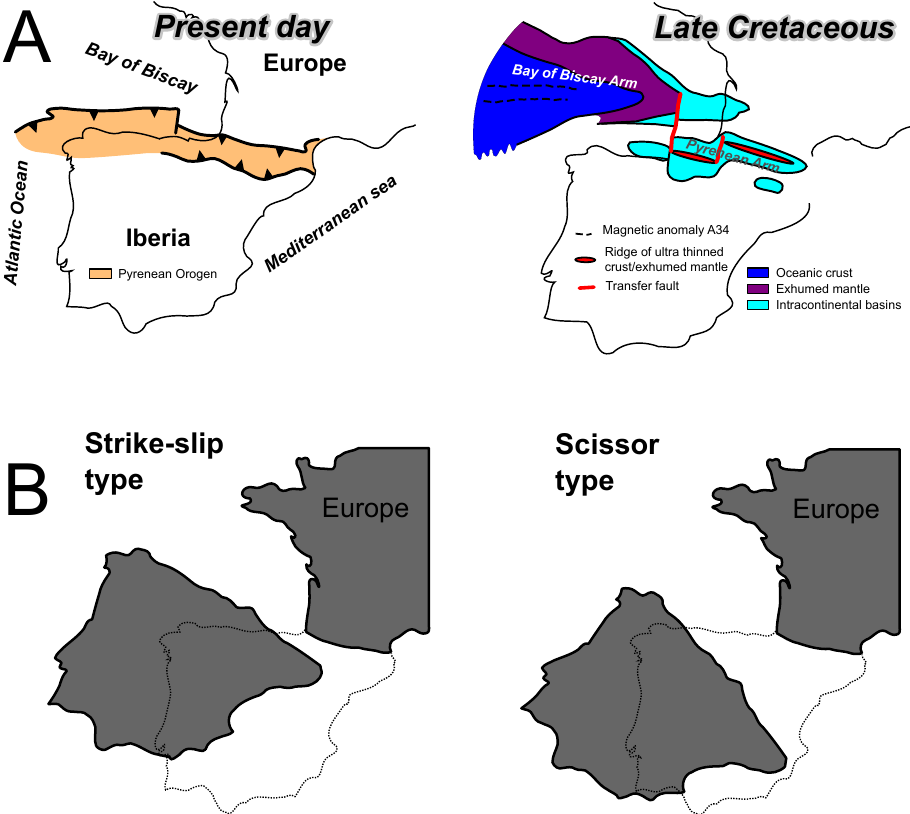
Fig. 1. (A) Present-day and reconstructed Late Cretaceous tectonic sketch map of the Iberia-Eurasia boundary. (B) Paleokinematic recon- struction of Iberia with fixed Eurasia at 118My (chron M0) according to the strike-slip and scissor type opening models (Modified from Jammes et al., 2009). Dotted lines indicate the present-day shoreline of